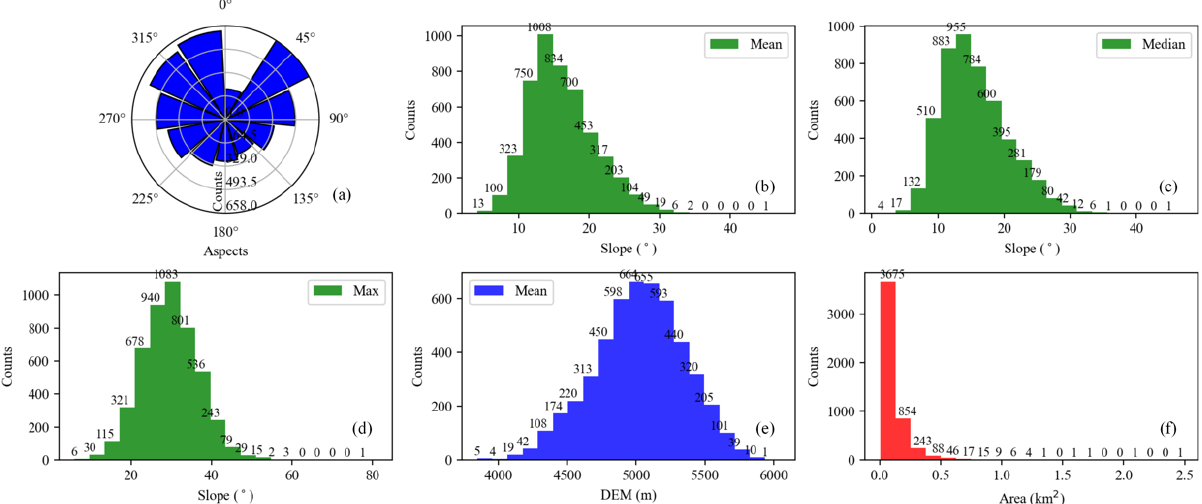
Figure 3. ( a ) The median aspects polar plots of rock glaciers. ( b – d ) are the mean, median, and maximum slope distributions. (e– f ) The elevation and area statistics of rock glaciers.